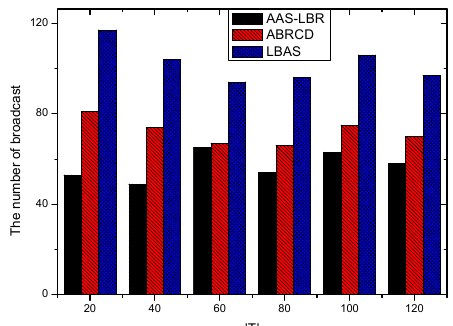
Figure 41. The impact of |𝑇| with fixed network nodes = 200 with fixed on the total number of broadcast.